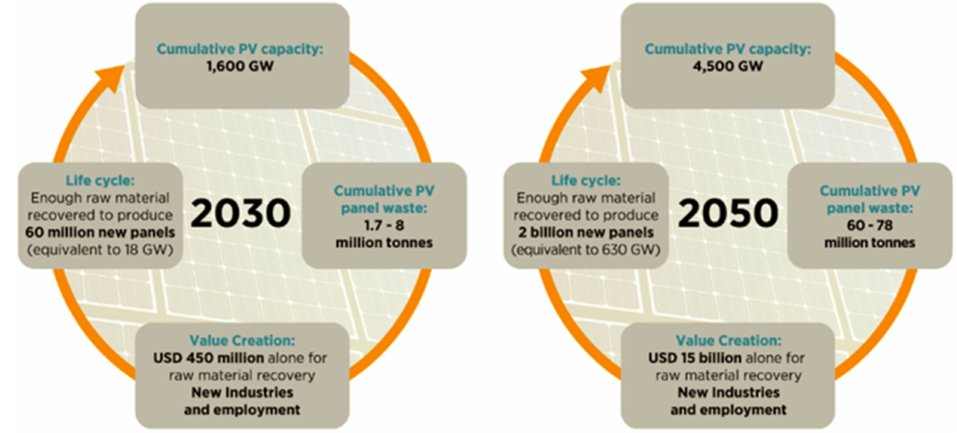
Figure 1. Potential value creation through PV end-of-life management. Source: irena.org